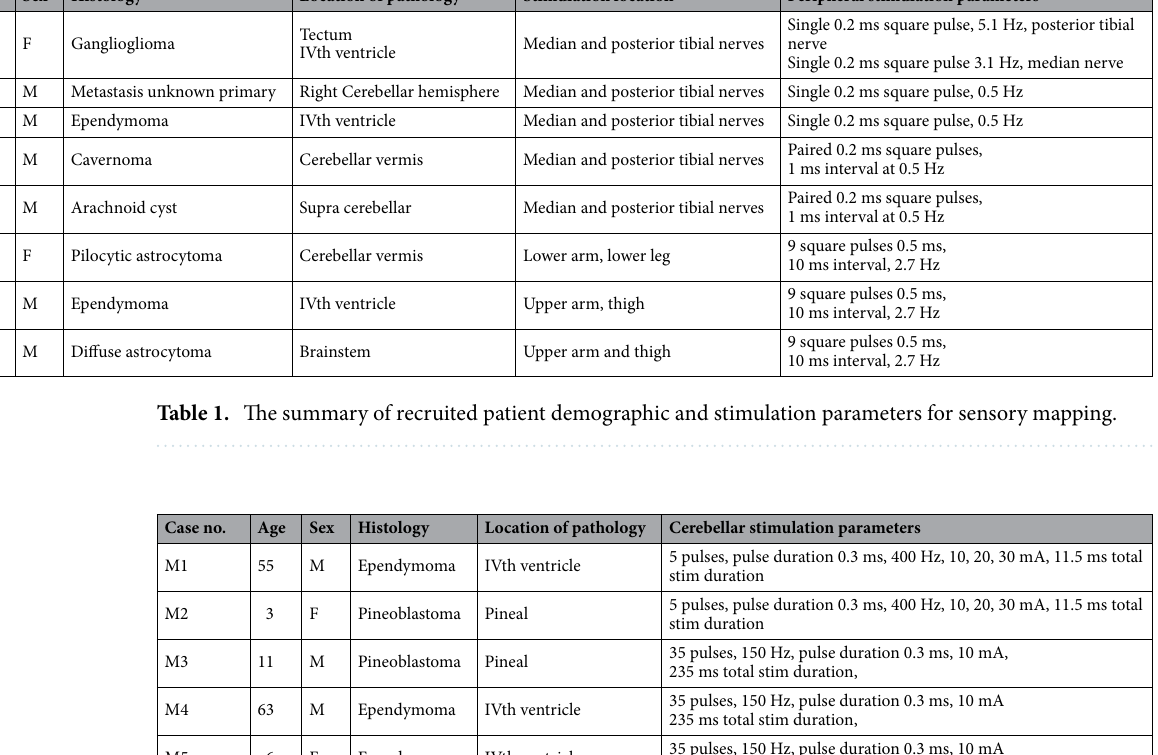
peripheral stimulus intensity was adjusted to evoke a small but detectable twitch in the corresponding body part. This was approximately 20 mA for the arms and 30–40 mA for the legs. Three patients (S6-8) underwent sensory mapping of the cerebellum using stimulus parameters based on the study performed by Mottolese et al. 18 (Table 1, nine pulses, 0.5 ms duration, ISI 10 ms, 2.7 Hz, at an intensity which produced a muscle twitch). Using these parameters, in one patient (S6) the forearm extensors and the tibialis anterior muscles in the lower leg were stimulated using twisted pair needle electrodes (Ambu, Copen- hagen, Denmark), in addition to median and posterior tibial nerves. More proximal limb muscles, biceps and quadriceps were stimulated for the two other patients (S7, S8). Table 1 indicates the stimulus parameters and limb stimulation sites used for all eight sensory mapping patients. Sensory mapping: cerebellar evoked potentials. Electrophysiological recording from the exposed surface of the cerebellum was carried out prior to tumour resection in the eight sensory mapping patients (Table 1). A bipolar 2 mm ball tipped stimulation probe (Inomed, Emmendingen, Germany) with 5–8 mm width between the two contact points was used for seven of the eight patients (S1-4, S6-7). Electrophysiological signals were recorded differentially between one of the contact points and an indifferent electrode placed nearby in the subcutaneous tissue alongside the incision. The data were amplified (×1000) and bandpass filtered (30 Hz to 3 kHz). The probe was held free hand for the first patient (S1) and gently placed at different positions on the cerebellar cortical surface. For the remaining patients (S2–S7), the probe was fixed in a flexible arm retractor to minimise movement artefacts during recording. In all cases, the bipolar probe was moved in increments of approximately 5 mm laterally and rostro-caudally in a systematic manner to cover the entire exposed cerebellar surface. A four-contact recording strip with 10 mm spacing (Ad-tech Medical Instrument Corporation, Oak Creek, USA) was used in one patient (S5). SEP recordings provided a positive control that the peripheral stimu- lation was effective in generating an ascending sensory volley (Fig. 2). Motor mapping: cerebellar stimulation. In five patients (M1-5) the cortical surface of the cerebellum was stimulated using a monopolar probe in order to evoke EMG responses from the nasalis and orbicularis oris, biceps, forearm (extensor digitorum communis and flexor carpi radialis), small hand muscles, quadriceps, tibi- alis anterior and abductor hallucis, using parameters based on human intraoperative transcranial MEP monitor- ing and animal and human cerebellar stimulation (Table 2 17,38 ).